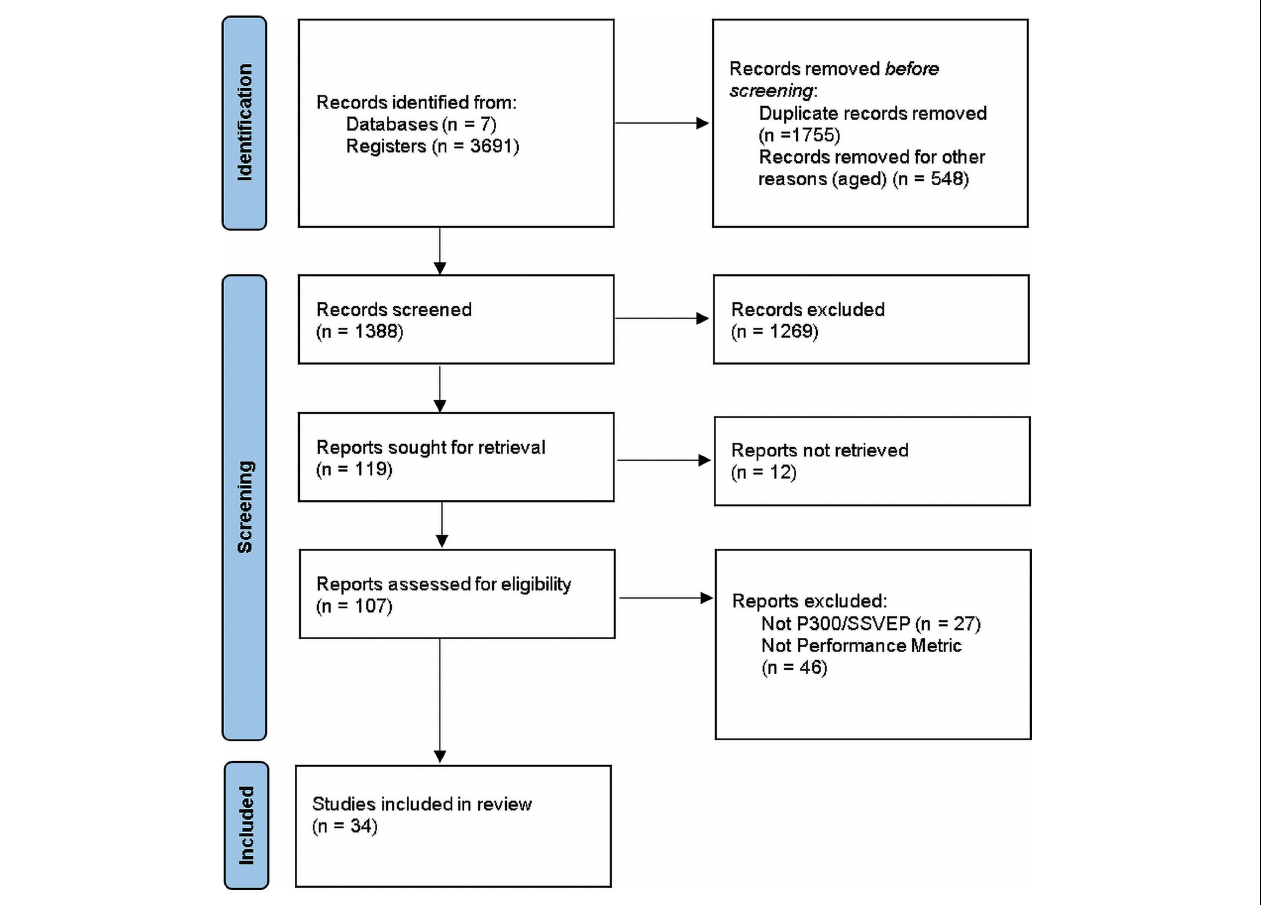
FIGURE 1 | PRISMA flow diagram for the Systematic Literature